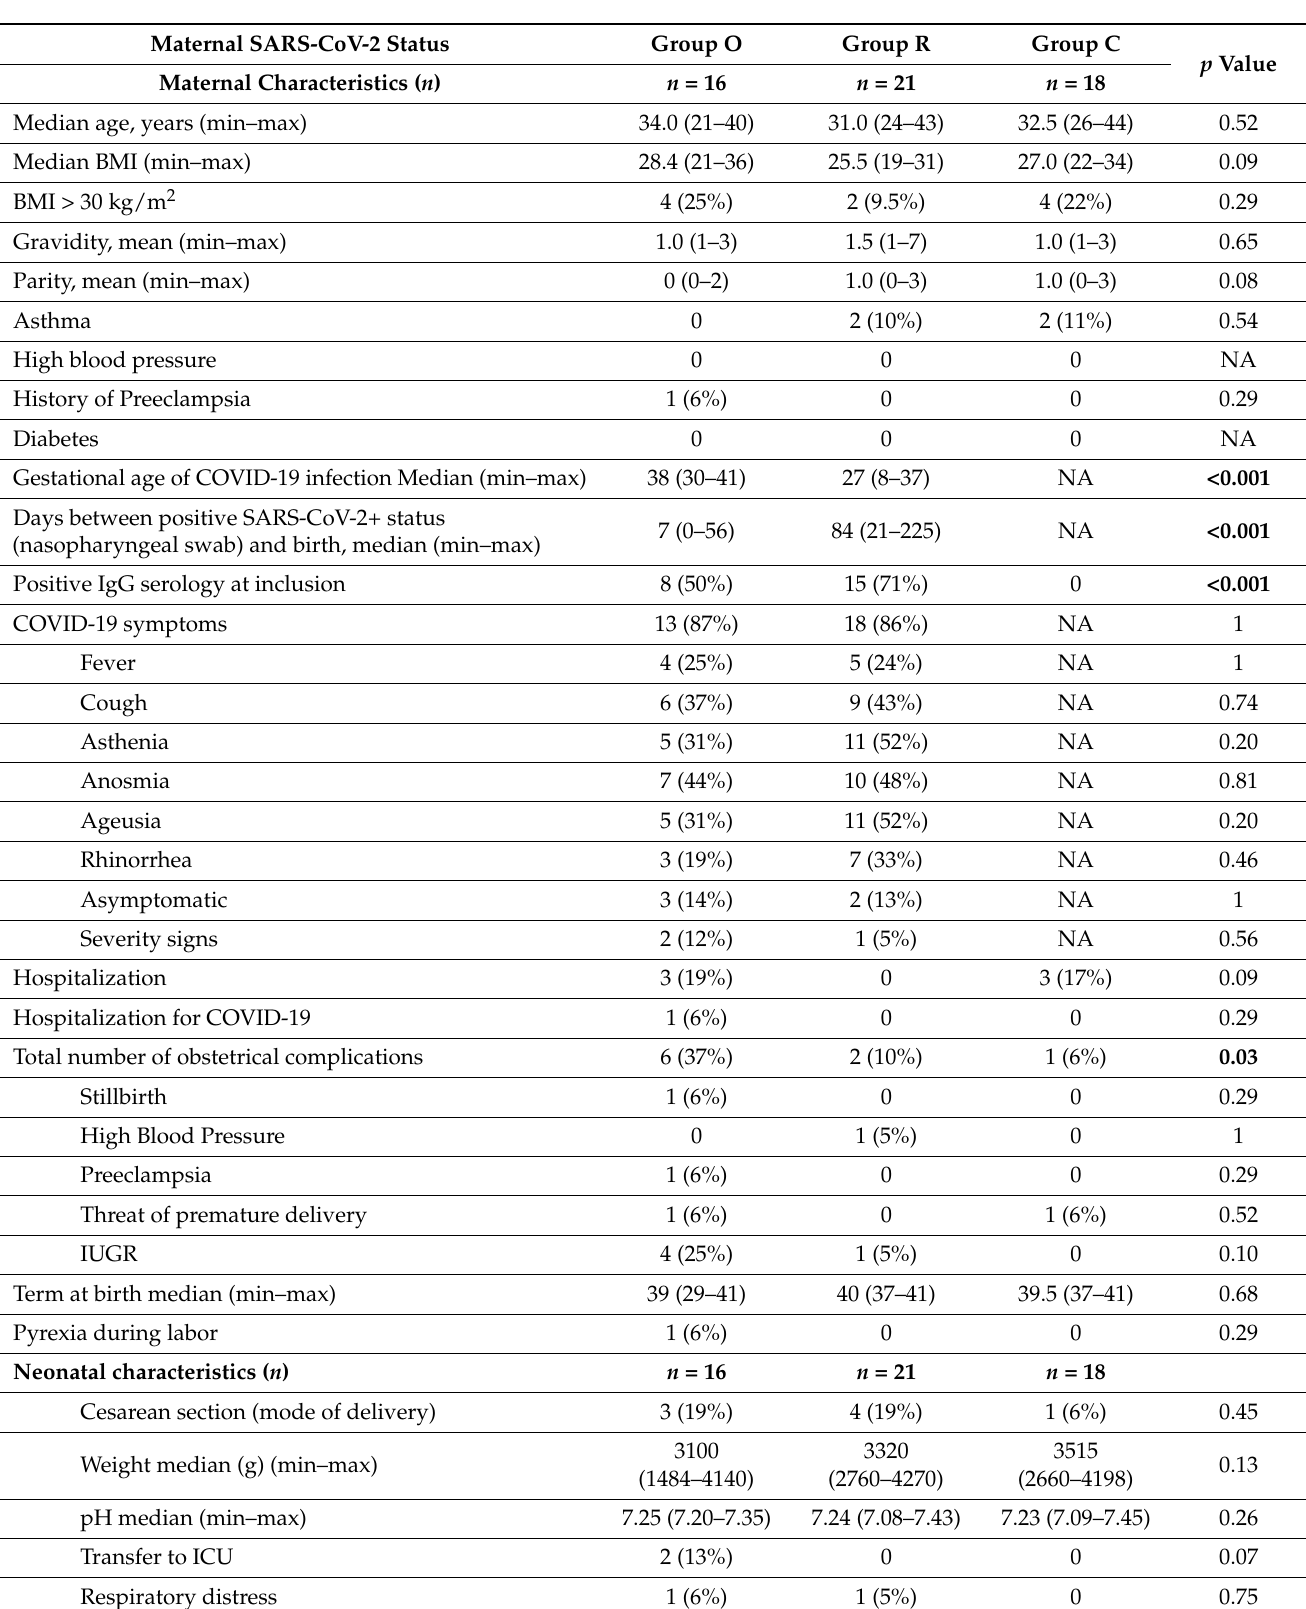
Table 1. Maternal and Neonatal clinical